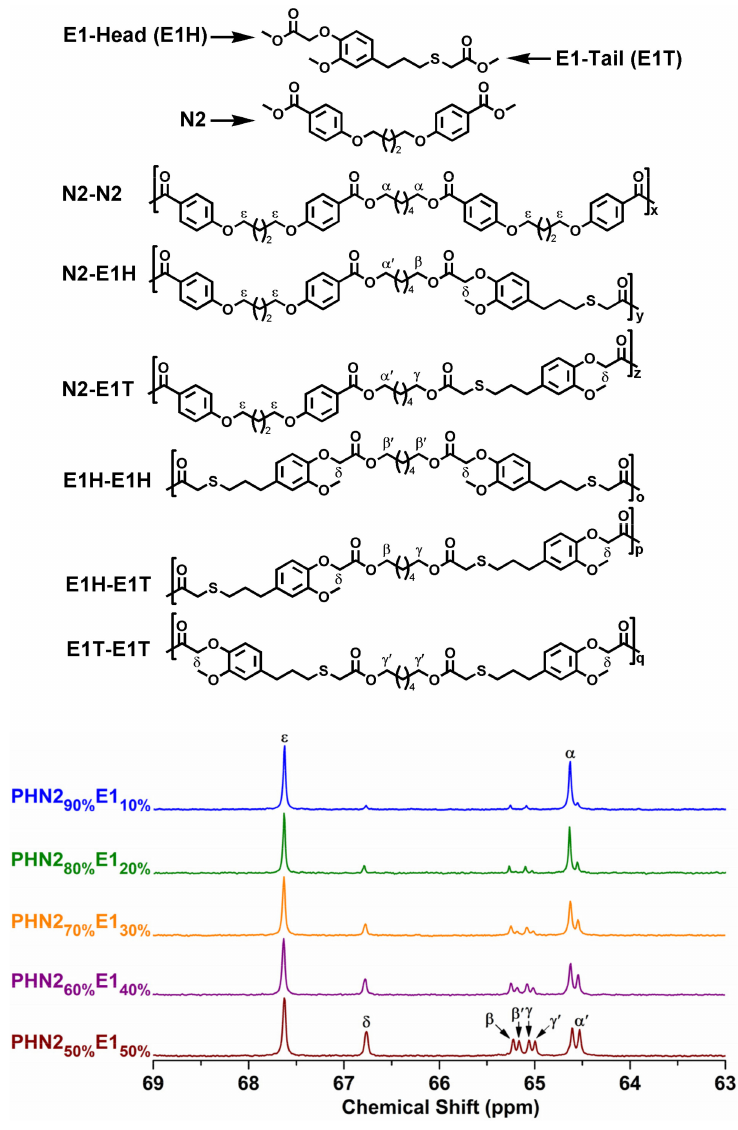
Figure 3. The splitting modes of the methylene carbons adjacent to the alcohol-oxygens for PHN2 1 − x E1 x with the indications of the dyads to which they are